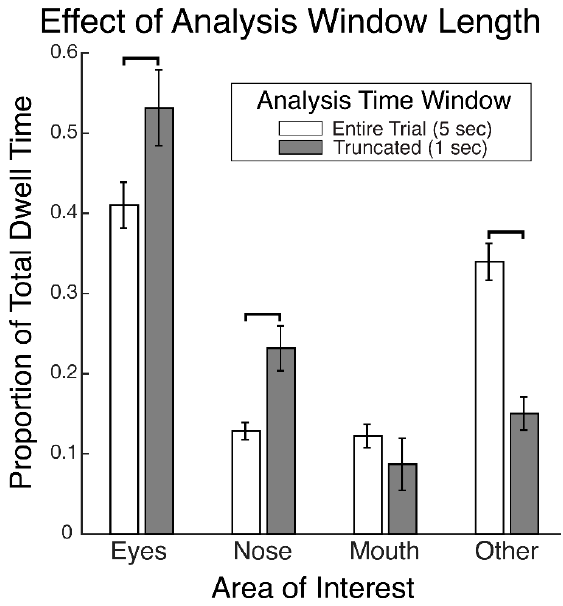
Figure 1. Effect of analysis time window length on the proportions of total dwell time across facial features. The comparison between five seconds of facial encoding (white bars) and the same, non-independent, data truncated to just the first second of encoding (gray bars) revealed highly significant differences in proportion of dwell time on the eyes ( p = 0.0003), nose ( p = 0.000027), and “other” facial areas of interest ( p = 9 × 10 − 14 ). The difference for the mouth area was only a trend ( p = 0.10). The pattern and magnitude of these differences match those interpreted as differences between encoding and recognition in Henderson, Williams, & Falk, 2005 [28]. Our illustration, instead, suggests that the differences reported by Henderson and colleagues are likely largely, if not entirely, analytic artefacts of the inconsistent time window lengths applied between their encoding and recognition phases.